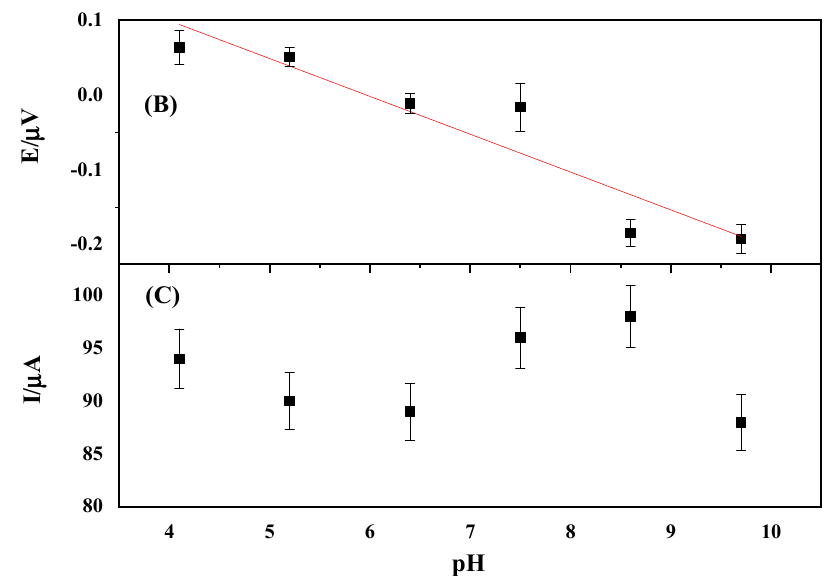
Figure 3. ( A ) Effects of the bioactive compounds from the pH ~5.2 on the depolarization potential of the MCF-7 cells. ( B , C ) The influence of the voltage on current of the MCF-7 cells as a function of pH. The cyclic voltammogram measurements conditions were: Scanning from 690 mV to 970 mV at a scan rate of 10 mV s − 1 . MCF-7 cancer cell viability studies of the bioactive compounds extracted at pH 5.2 at cell concentration of 1 × 10 6 cells/well.